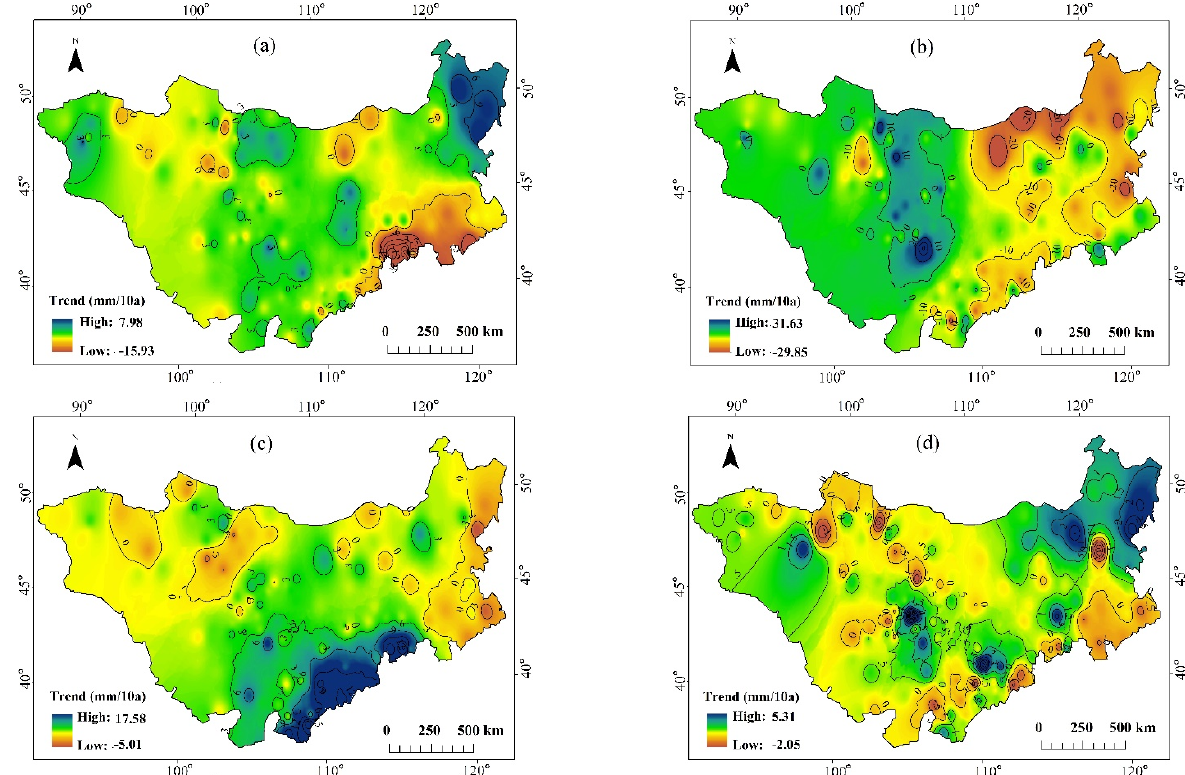
Figure 6. Spatial pattern of average precipitation change trend of 135 stations during 1976–2017 in